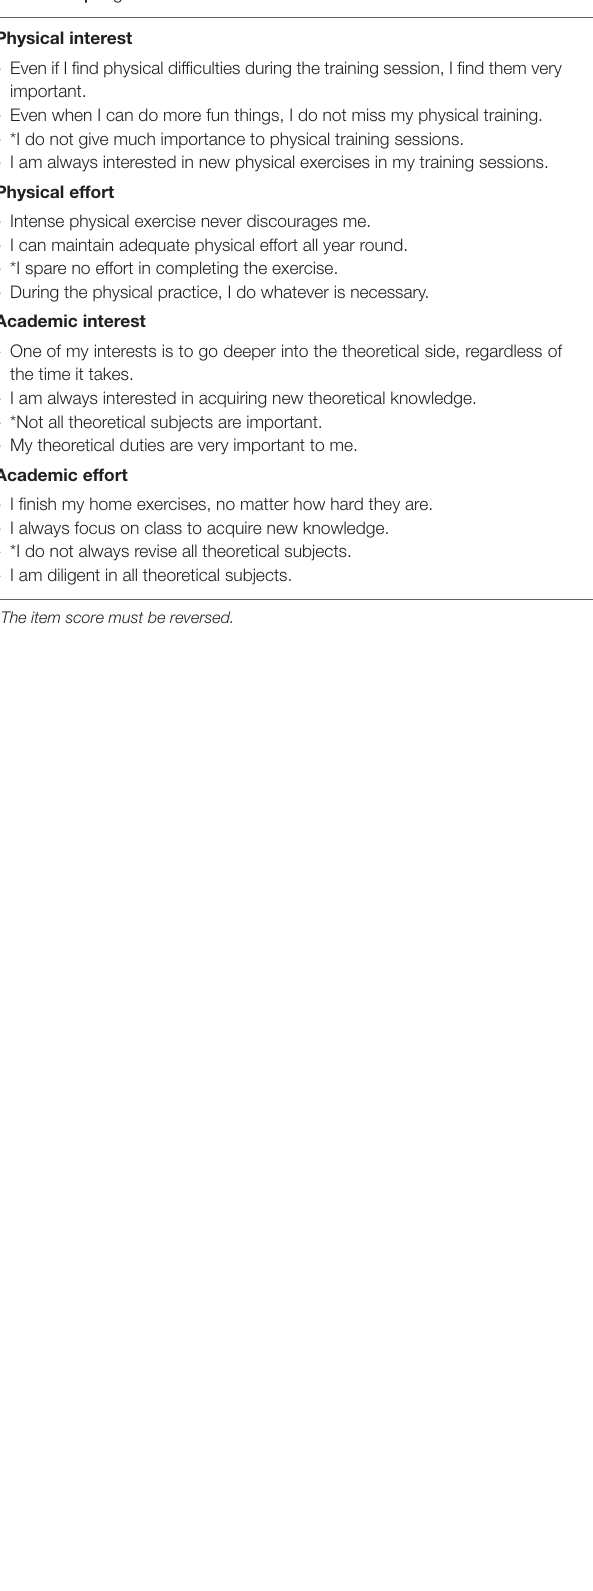
TABLE A1 | English version of the PE-Grit.